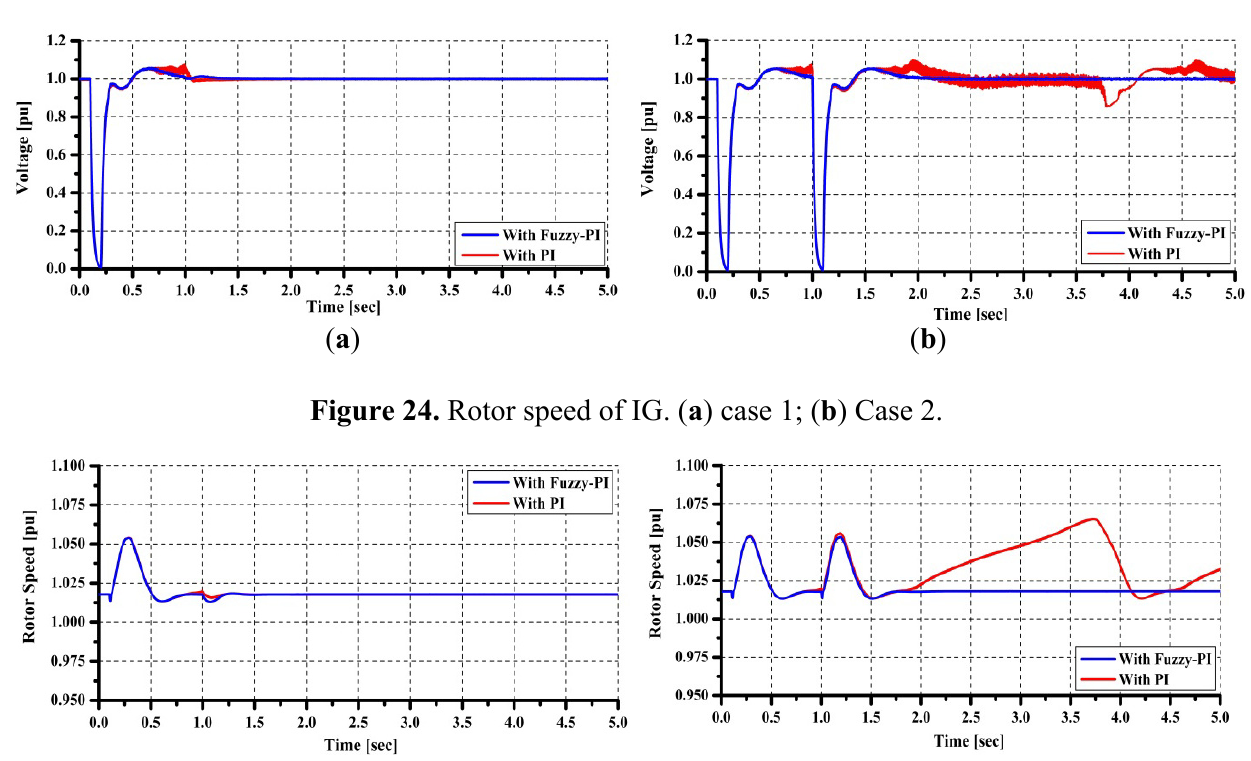
Figure 23. Terminal voltage at PCC. ( a ) case 1; ( b ) Case 2.